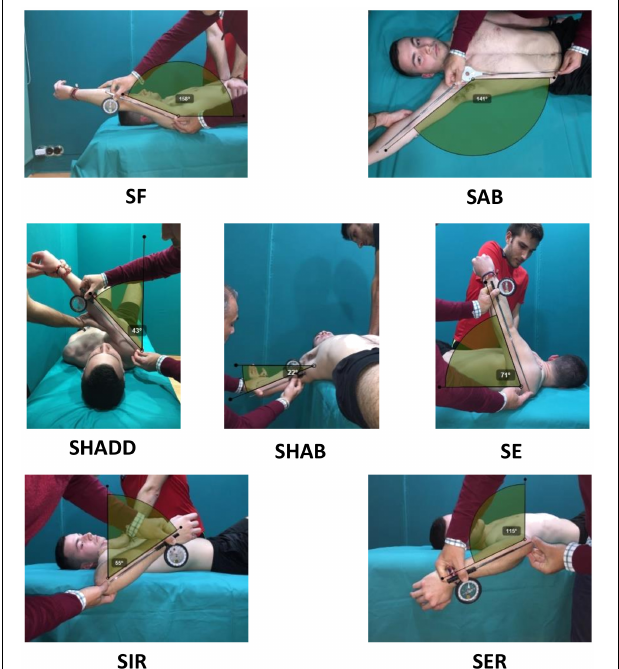
FIGURE 1 | Shoulder ranges of motion of the “ROM-SPORT” protocol: SF, shoulder flexion; SAB, shoulder abduction; SHADD, shoulder horizontal adduction; SHAB, shoulder horizontal abduction; SE, shoulder extension; SIR, shoulder internal rotation; SER, shoulder external rotation. Written and informed consent has been obtained for the publication of these images from the depicted adults and from the parents/legal guardians of the minors.